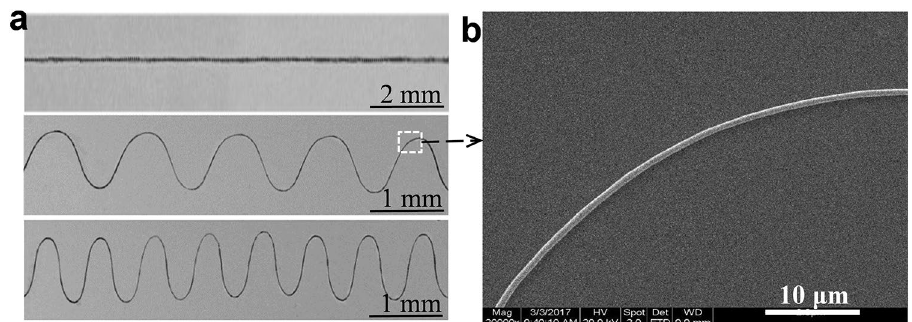
Figure 12. 2D patterned fiber prepared by magnetic spinning and SEM image.